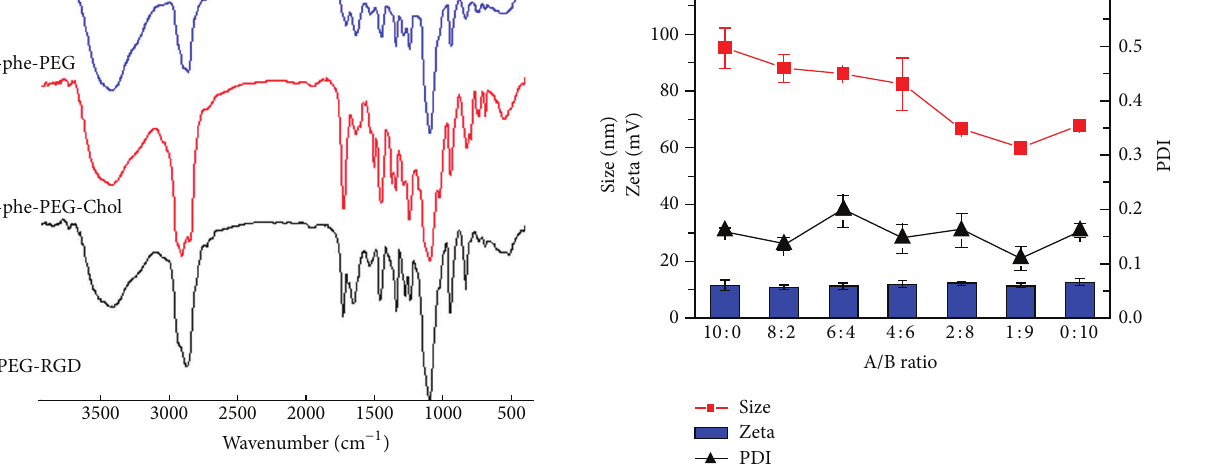
Figure 3: Screening of blank liposome.